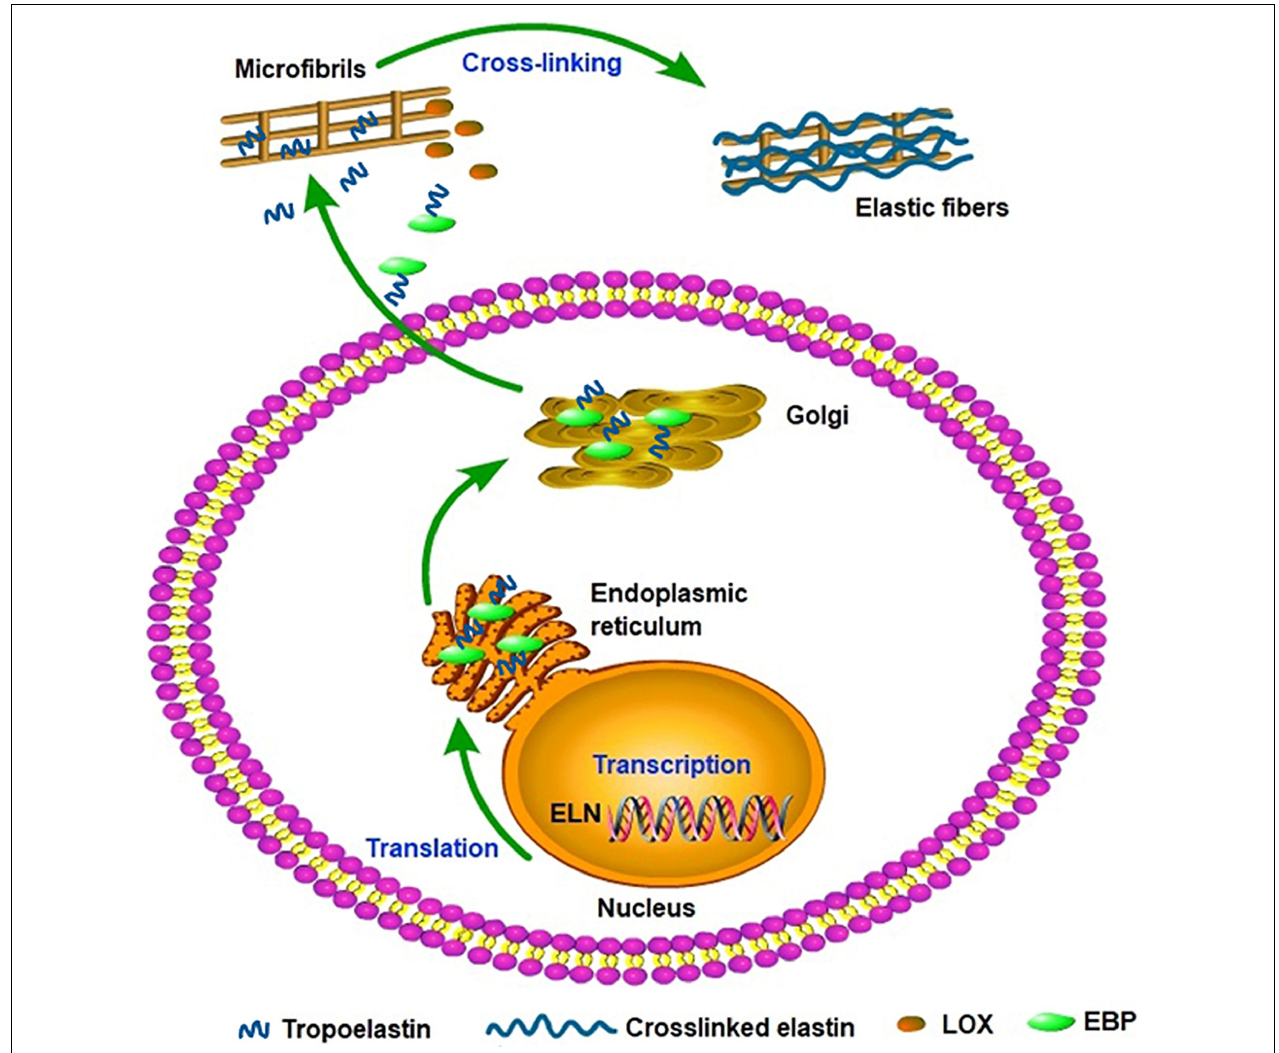
FIGURE 2 | Tropoelastin secretory/assembly pathway. The synthesis of tropoelastin begins with the transcription of the ELN gene in the nucleus. In the endoplasmic reticulum, tropoelastin interacts with EBP and folds in structure. After the storage and transport of Golgi, the complex of EBP and tropoelastin is secreted to the cell surface for self-assembly. Then, tropoelastin dissociates from EBP and deposits onto the microfibril scaffold. In the presence of LOX, tropoelastin cross-links and eventually forms mature elastic